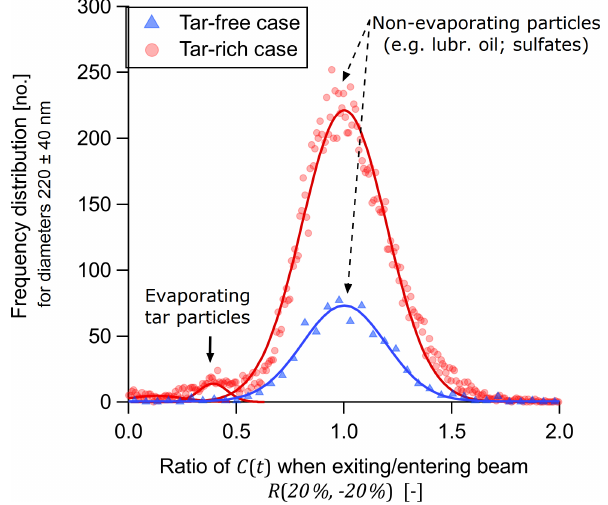
Figure 2. Frequency distribution of the ratio of scattering cross sec- tions, R ( − 20%, 20%), for non-incandescing particles of diame- ter 220 ± 40nm. Triangles and circles represent engine conditions where the mass fraction of tar brC relative to tar brC plus soot BC was zero or 0.75, respectively. Ratios were calculated by dividing the second scattering cross section measurement at 20% of maxi- mum beam fluence (particle exiting the SP2 laser) by the first (par- ticle entering the SP2 laser). Random error in R ( − 20%, 20%) was modelled by Gaussian fits, which indicated that about 3 . 6% of tar- rich case particles evaporated to less than half of their original cross section. Note that this 3 . 6% reflects the fact that the majority of par- ticles in this sample were non-absorbing lubrication-oil particles. In the tar-free case, no non-incandescing particles evaporated.